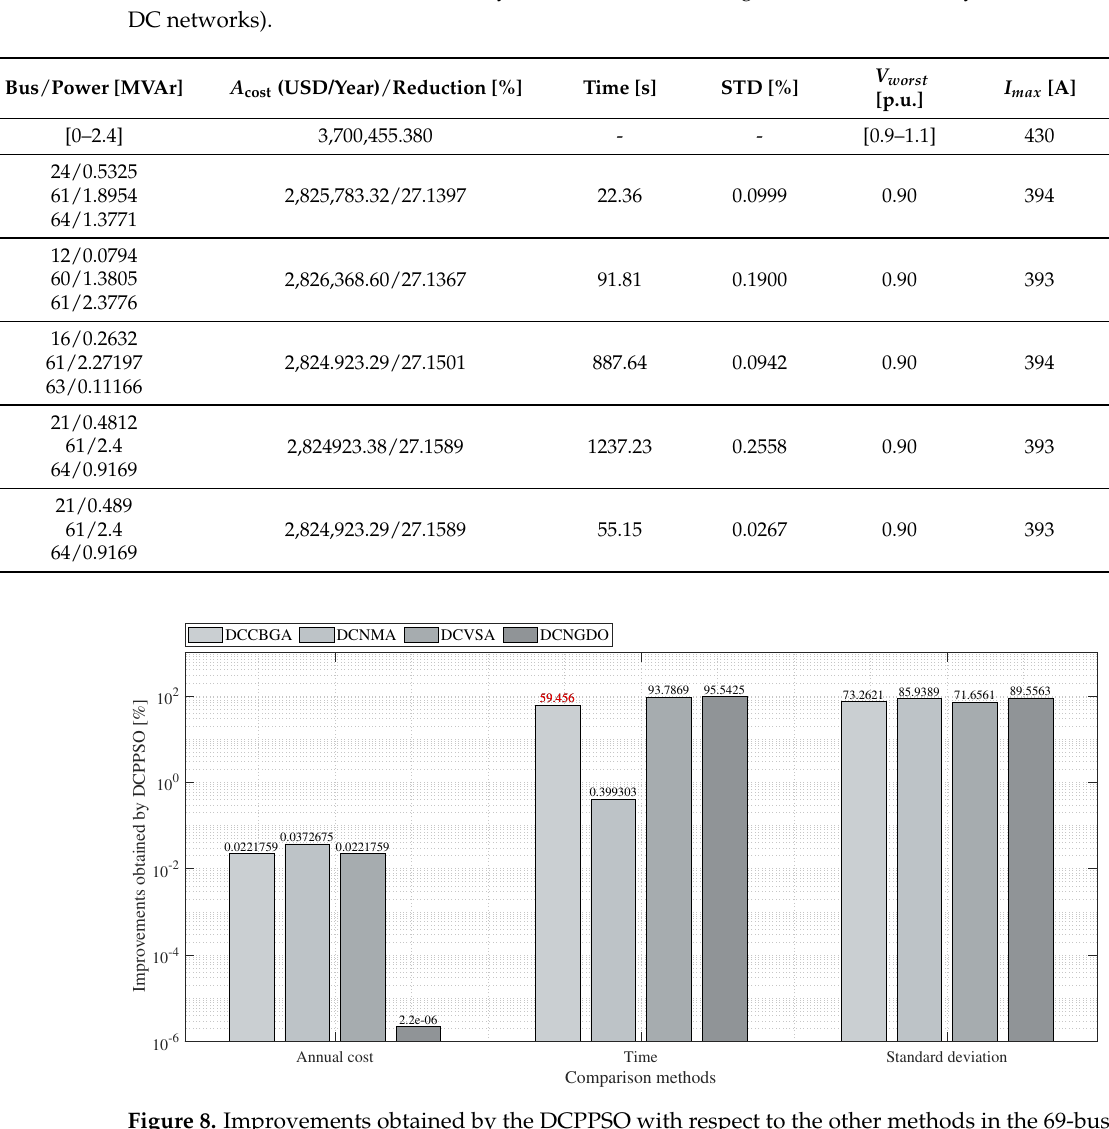
Figure 8. Improvements obtained by the DCPPSO with respect to the other methods in the 69-bus test